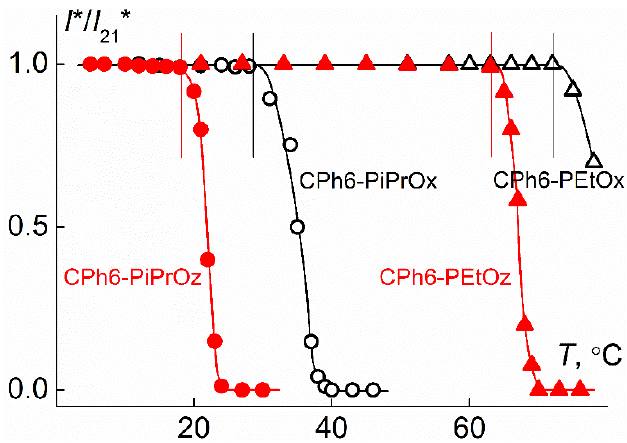
Figure 9. Dependences of relative transmittance I * / I 21 * for aqueous solutions of studied polymer stars. I 21 * is intensity of optical transmittance at T = 21 °C.